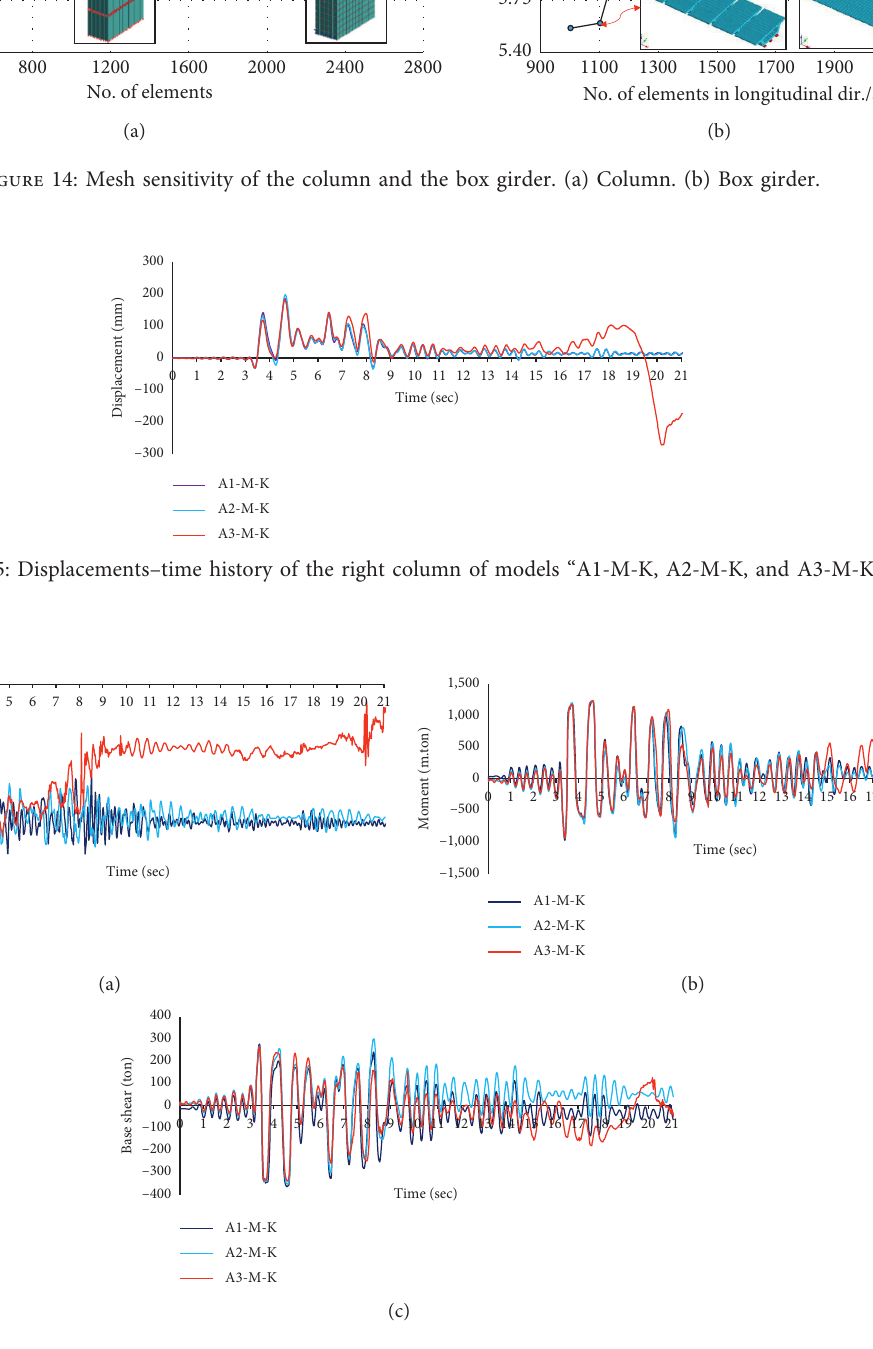
Figure 16: (a) Axial force–time history of the right column of models “A1-M-K, A2-M-K, and A3-M-K.” (b) Moment–time history of the right column of models “A1-M-K, A2-M-K, and A3-M-K.” (c) Base shear–time history of the right column of models “A1-M-K, A2-M-K, and A3-M-K.”